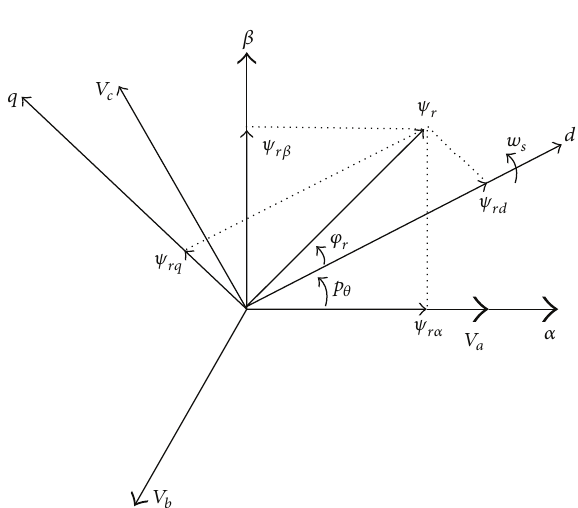
Figure 3: Phase depiction of components of 𝑑 - 𝑞 axis frame in rotor flux